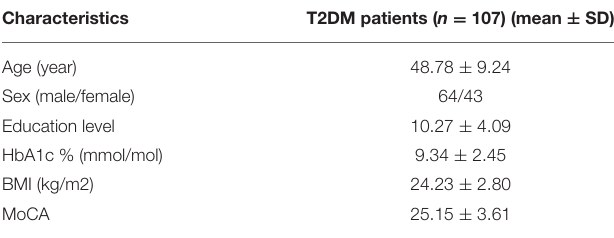
TABLE 2 | Characteristics of included T2DM